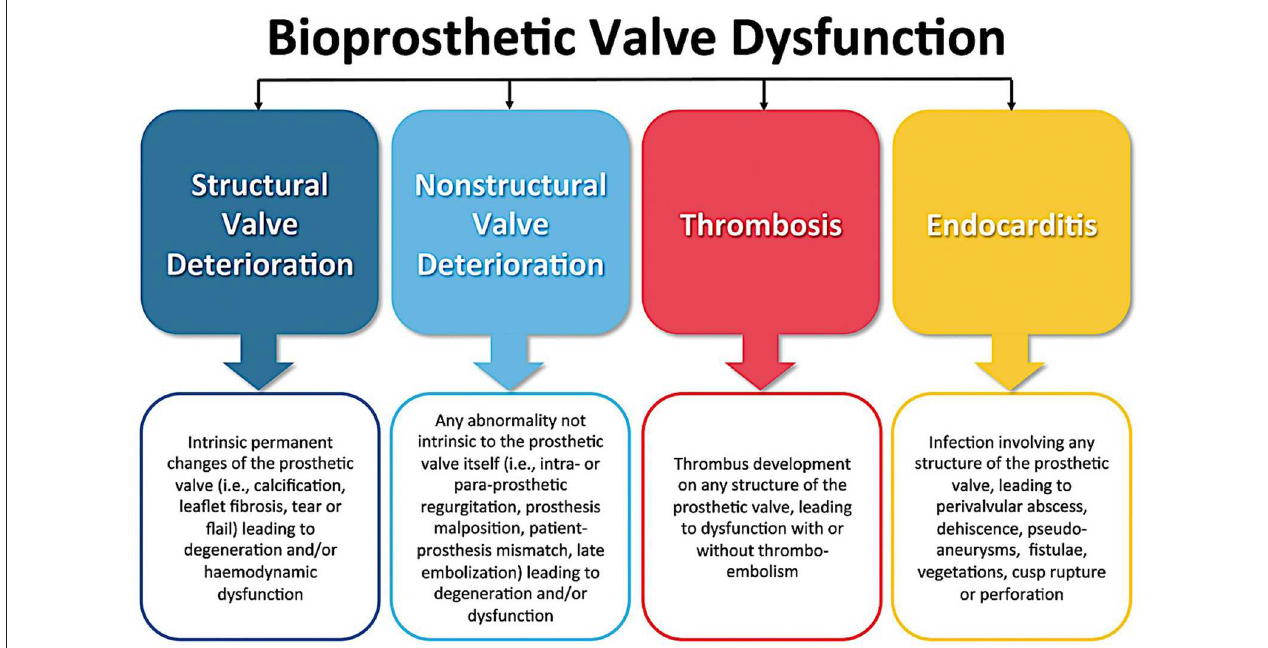
FIGURE 1 | Causes of bioprosthetic valve dysfunction. Figure used with permission from Oxford University Press